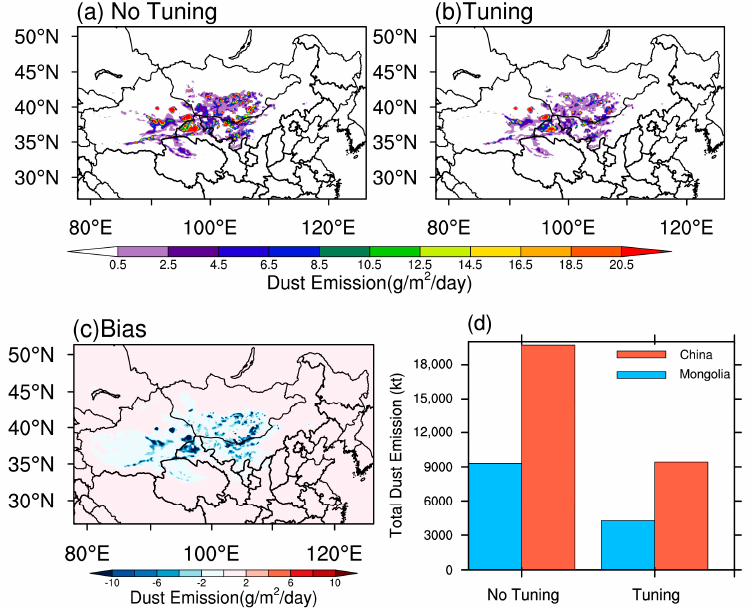
Figure 10. The spatial distributions of mean dust emissions in no tuning test ( a ) and tuning test ( b ) and the bias spatial distributions ( c ; bias = dust emission (tuning)-dust emission (no tuning)) on 14–16 March 2021. ( d ) Total dust emission in China and Mongolia during the dust event; the red box is China and the blue one is Mongolia.